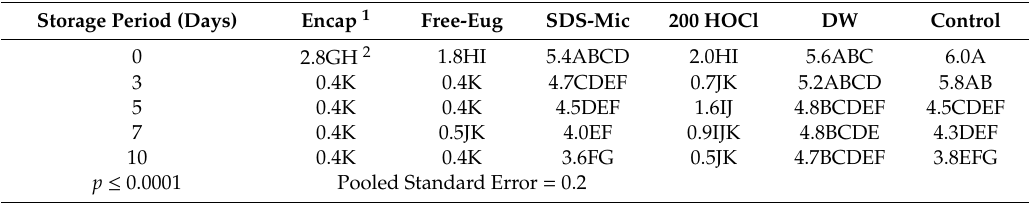
Table 1. Least-squares means of surviving Salmonella Saintpaul (log 10 CFU / cm 2 ) on spinach surfaces as a function of the interaction of antimicrobial treatment and days of aerobic storage at 5 ◦ C. Storage Period